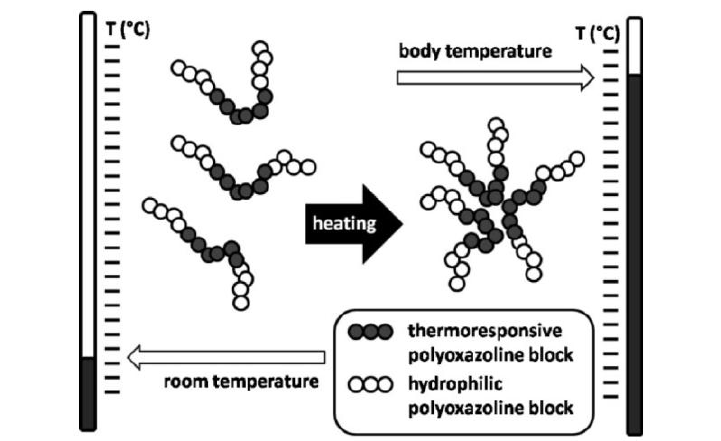
Figure 4. Temperature induced micellization of poly(2-oxazoline) triblock copolymers comprising hydrophilic PMeOx outer blocks and thermoresponsive PiPrOx-based middle block [73], reproduced by permission of